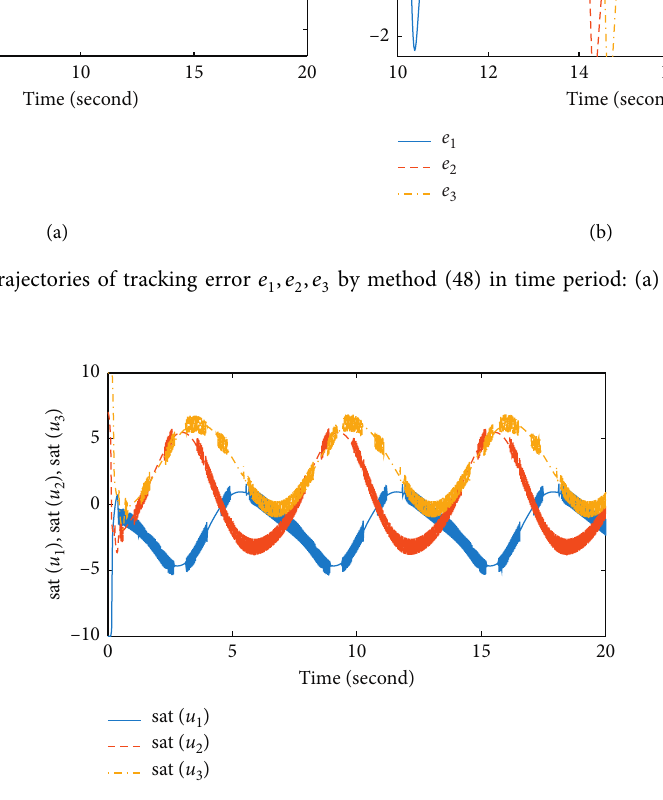
) , sat ( u ) , and sat ( u ) by using method 1 2 3